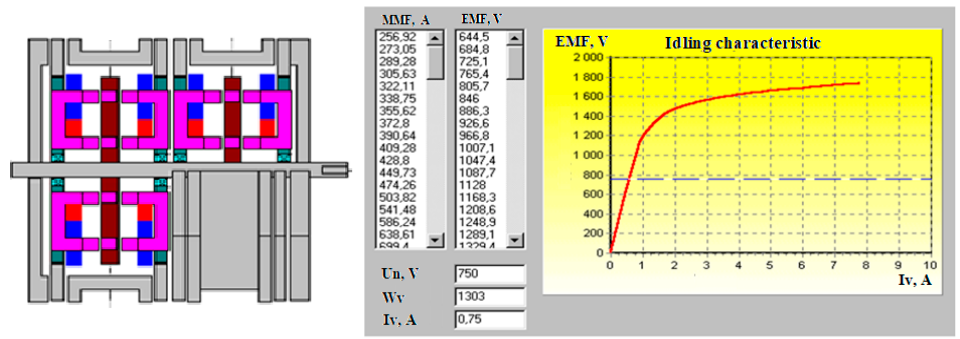
Figure 3. Sketch and characteristics of the generator.